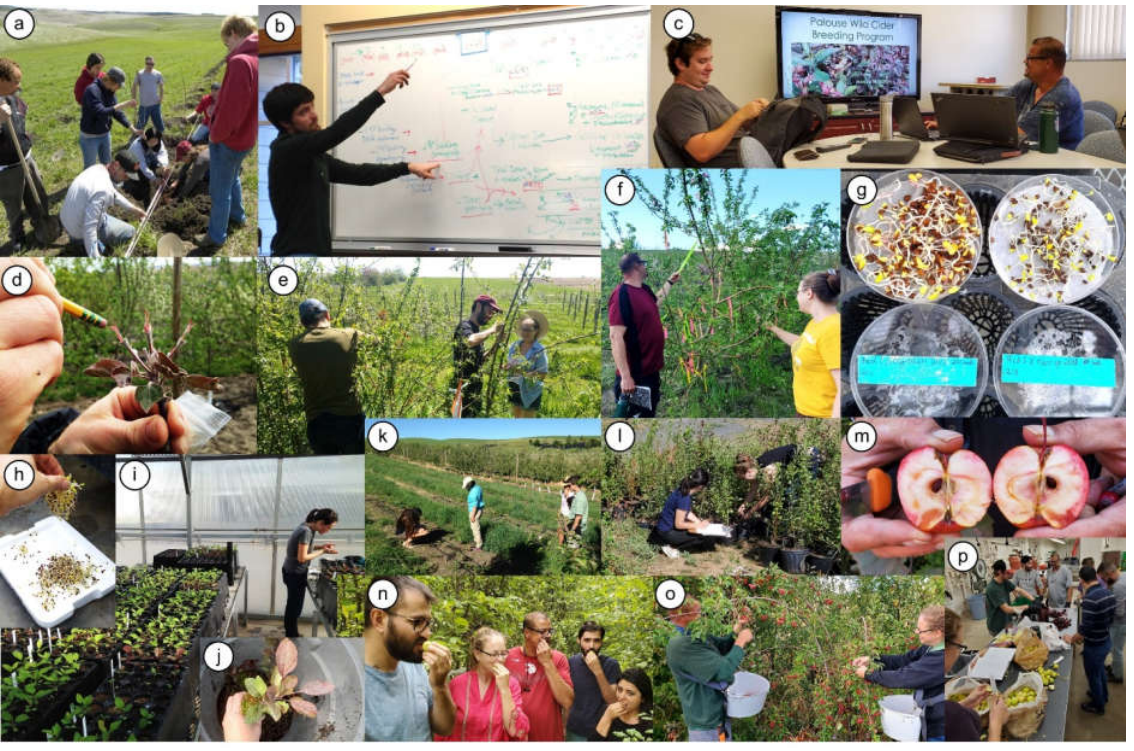
Figure 1. Experiential learning by students conducting operations in the Palouse Wild Cider apple breeding program. Goal setting : ( a ) planting in 2010 of the program’s base germplasm—grafted trees of most of the USDA National Plant Germplasm System’s apple core collection; ( b ) charting the breeding program’s course by the inaugural class of 2014, guided by trainee Paul Sandefur (P.S.); ( c ) reevaluating target attributes in early 2019, with trainees Alexander Schaller and Tymon James (T.J.) at the front of the classroom. New genetic variation : ( d ) pollinating emasculated flowers of ‘Robert’s Crab’ in